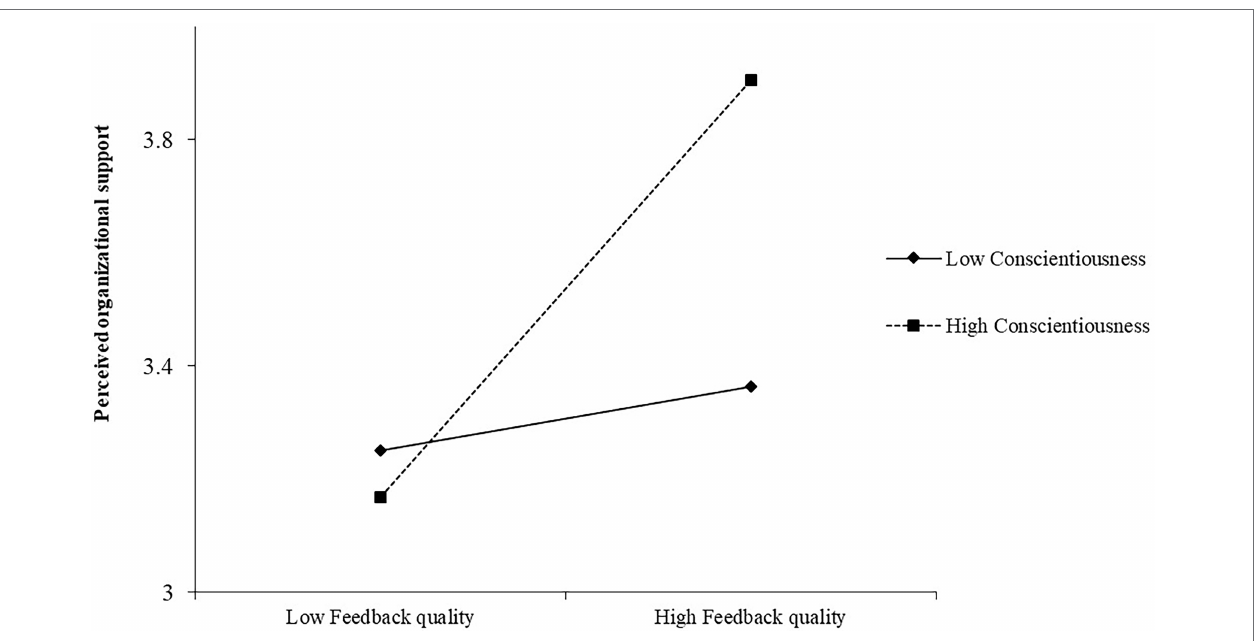
FIGURE 2 | The direct effect of feedback quality on perceived organizational support when conscientiousness is low and